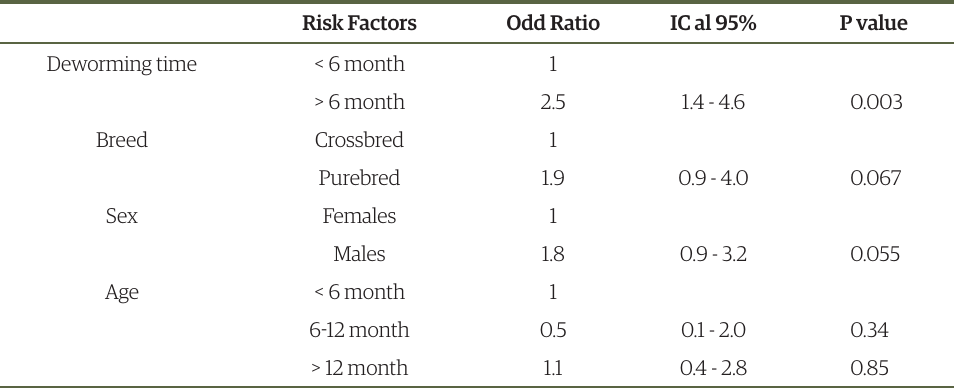
Table 2. Risk factors for presence of gastrointestinal parasites in owned dogs from urban